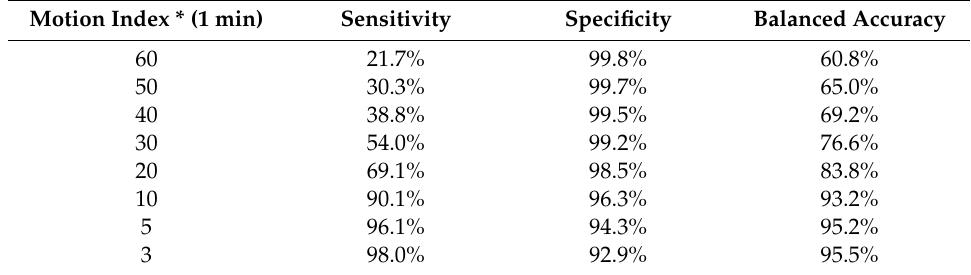
Table 5. Sensitivity and specificity calculations for selected motion index cut points for 1 min sampling intervals (number of sample points = 5938).